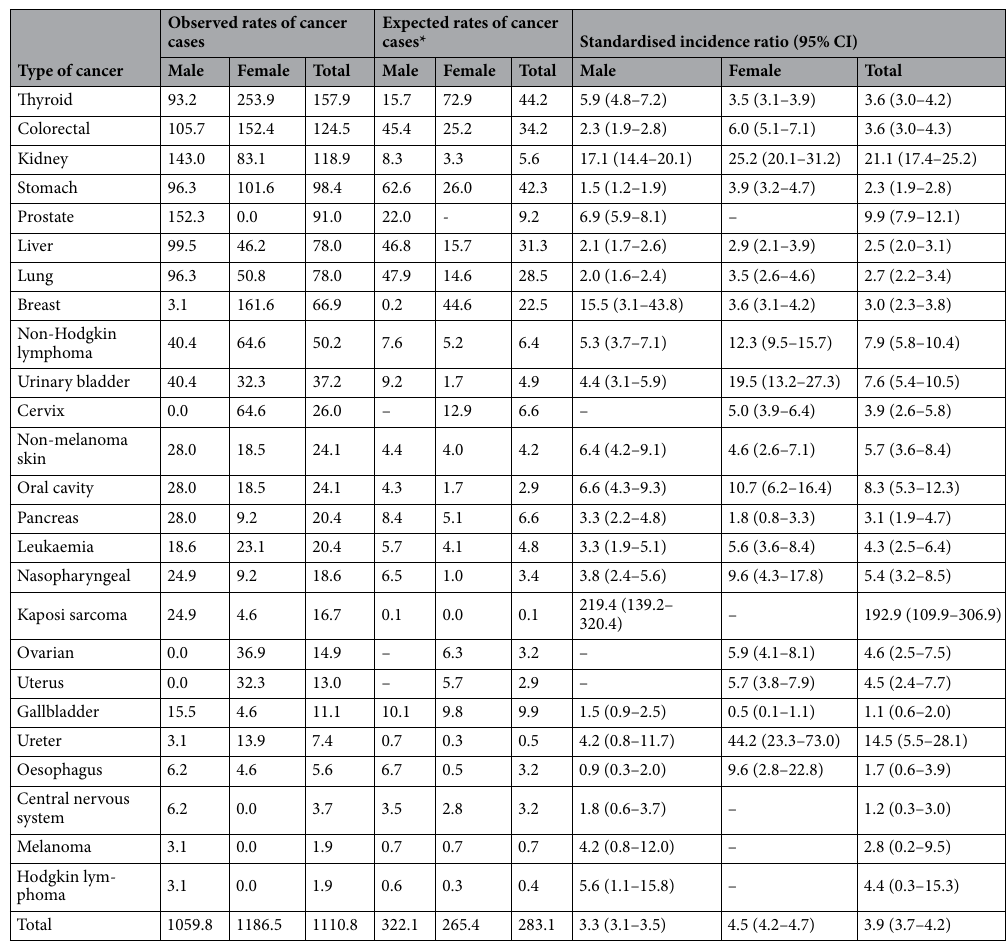
Table 3. Standardised incidence ratios according to the type of post-transplant malignancy. CI confidence interval. *The expected rates of cancer cases are based on the general population in Korea, adjusted for age and